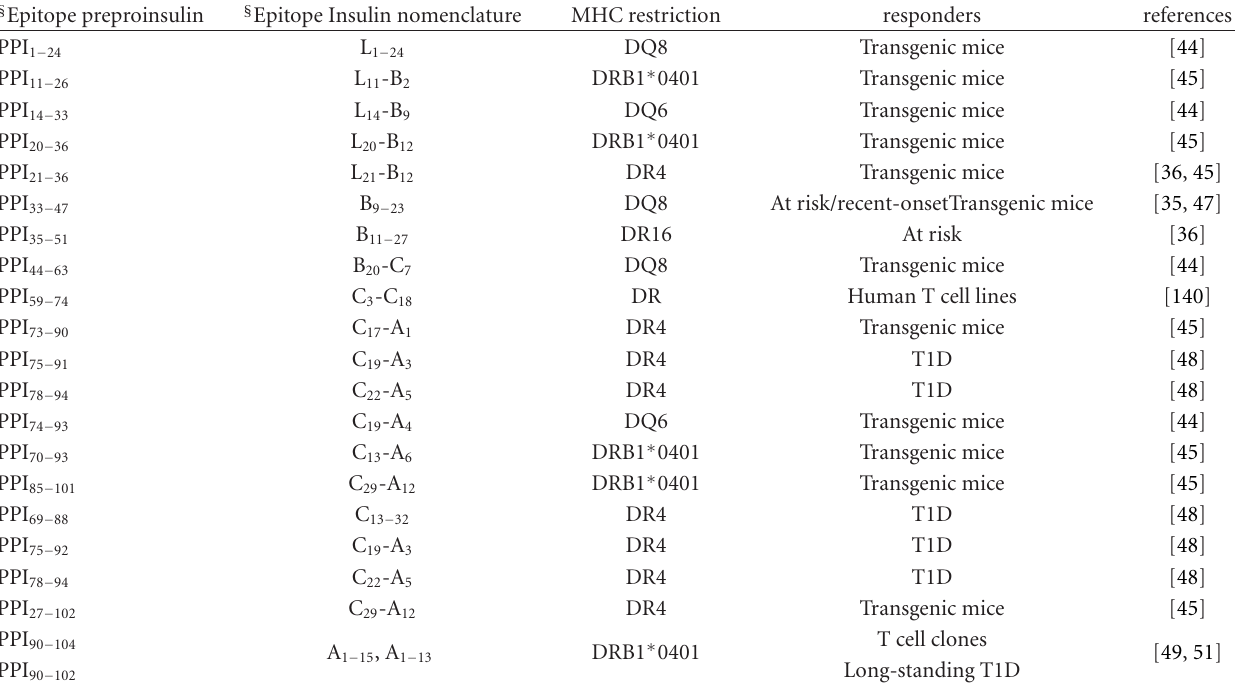
Table 2: Class II-restricted ∗ CD4 + T-cell epitopes on human